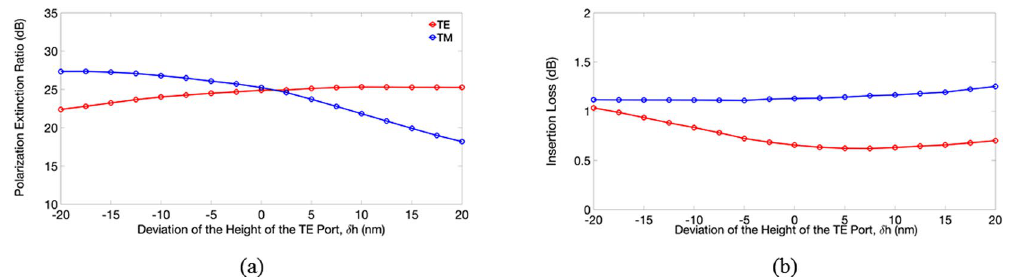
Figure 8. The calculated ( a ) PERs and ( b ) ILs of the TE and TM modes versus the deviation of the height of TE port, δ h .